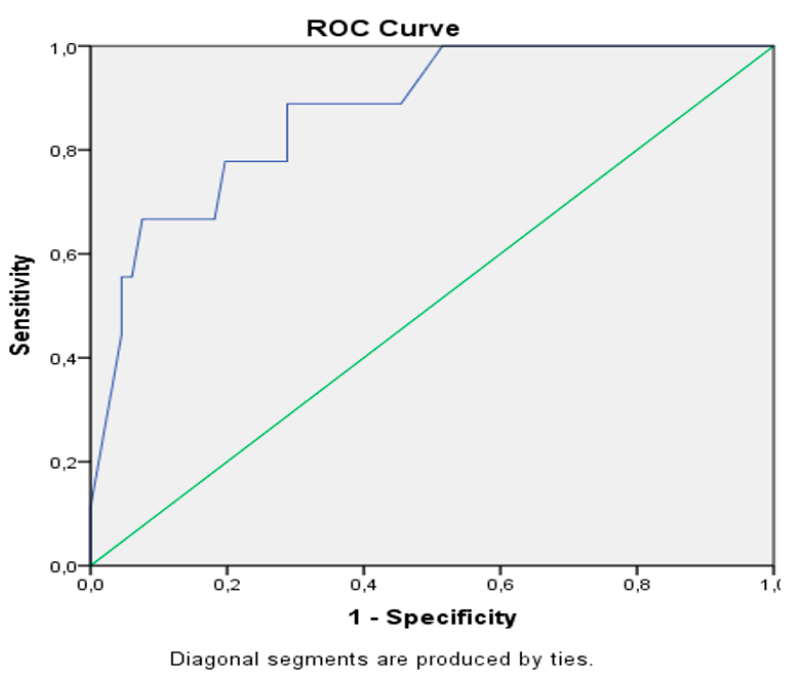
Figure 3. ROC curve mortality. MELD score combined with portal hypotension, AUC = 0.873.